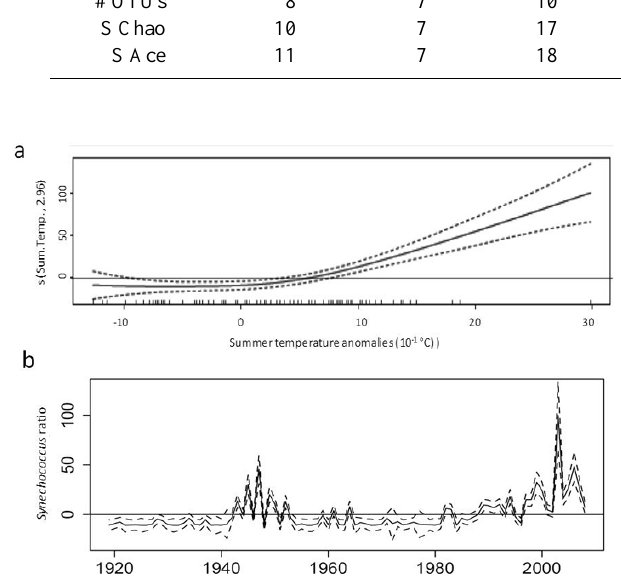
Fig. 3. GAM results: (a) Fitted smooth function for Synechococcus relative abundance (% of total cyanobacteria as revealed by qPCR counts). The dashed lines are approximate 95% pointwise confi- dence intervals on the fitted function. The tick markes inside the panel on the x-axis show the distribution of observed values for the covariates. The number in brackets on the y-axis (2.96) is the effective degree of freedom for the smooth function. (b) Contribu- tion of summer air temperature anomalies to Synechococcus relative abundance. The dashed lines are approximate 95% pointwise con- fidence intervals on the contribution. Where the interval confidence includes the dashed zero line, the contribution of the covariate is not statistically significantly different from the